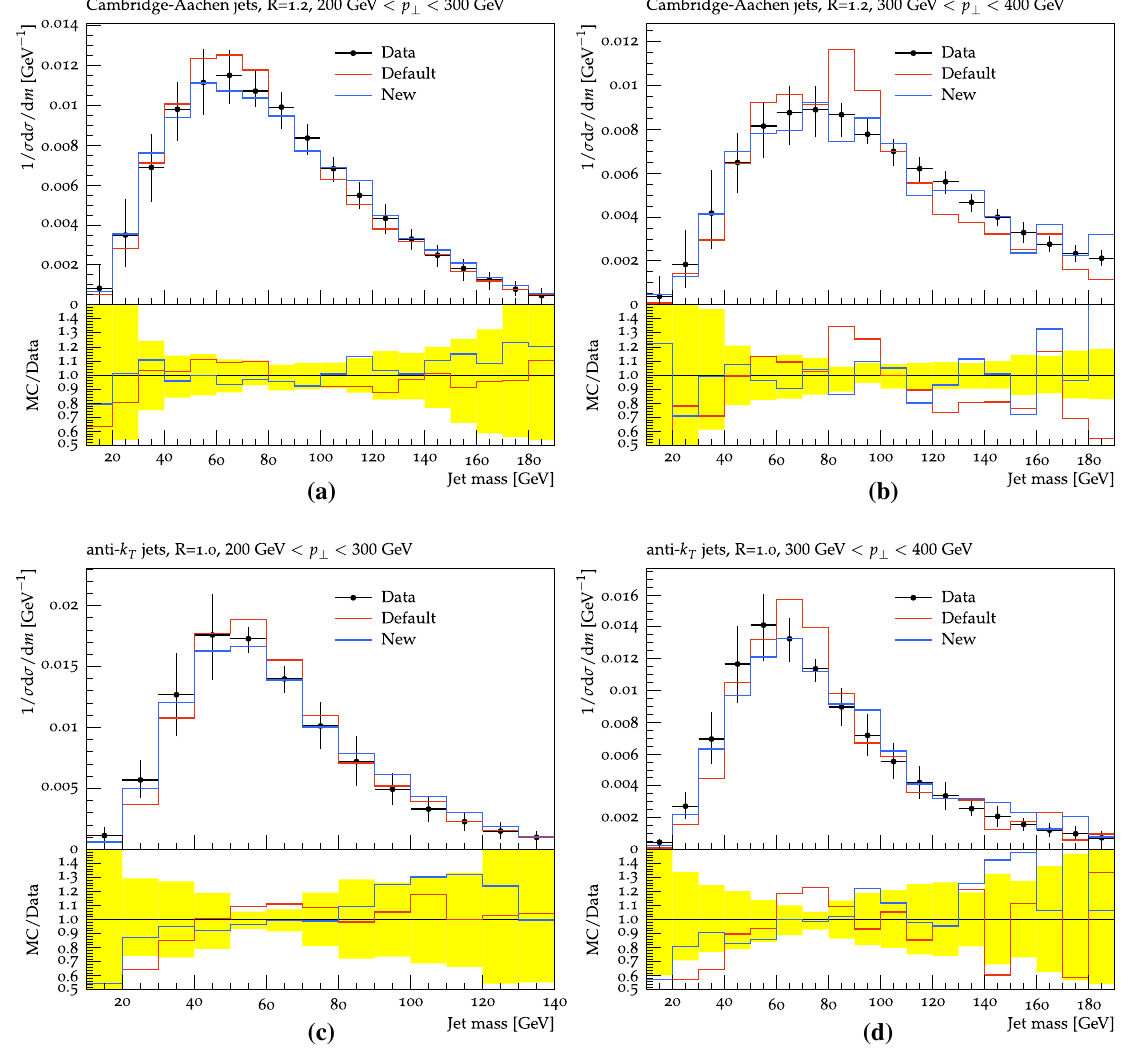
Fig. 14 Jet mass spectra measured in QCD events by ATLAS for pp collisions at 7 TeV [44,51]. The jets have been reconstructed with: a , b Cambridge-Aachen with R = 1 . 2, c , d anti- k ⊥ with R = 1 .